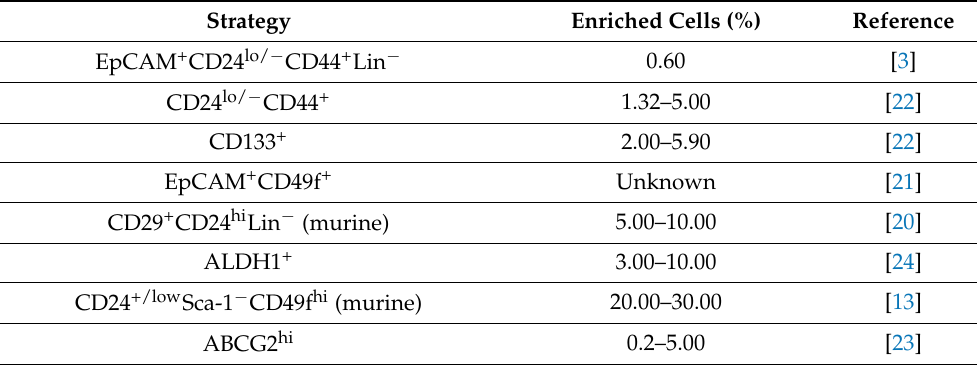
Table 1. Methods for the isolation or enrichment of human and murine breast cancer stem cells using cell surface and intracellular